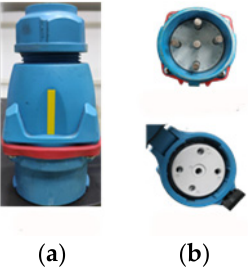
Figure 1. Example of highly axisymmetric properties. ( a ) Plug front view. ( b ) Plug and socket phase sequence.